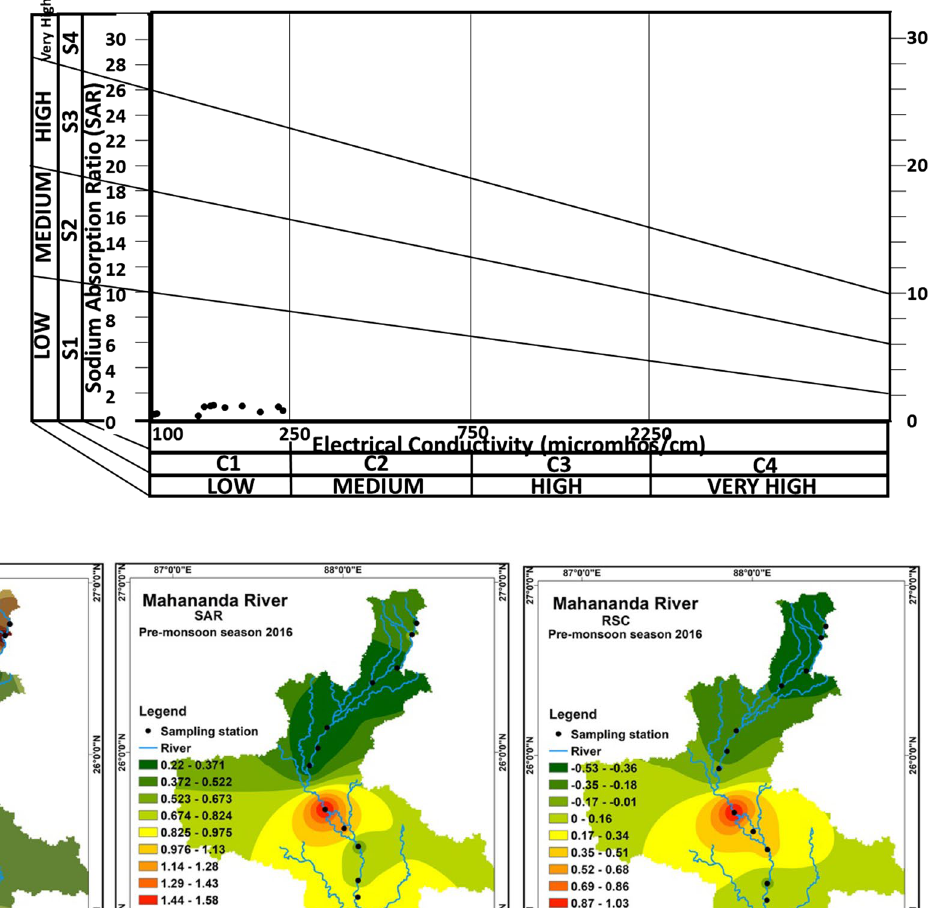
Fig. 9 USSL diagram of sam- ples of post-monsoon season